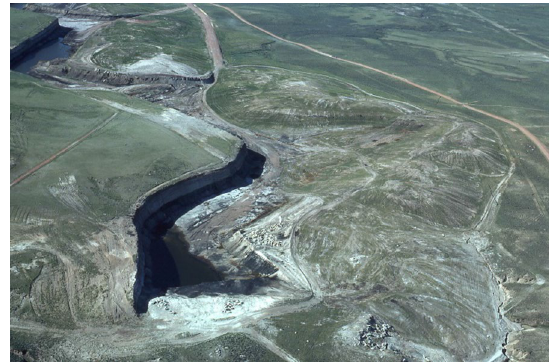
Fig. 7 Post-SMCRA reclaimed